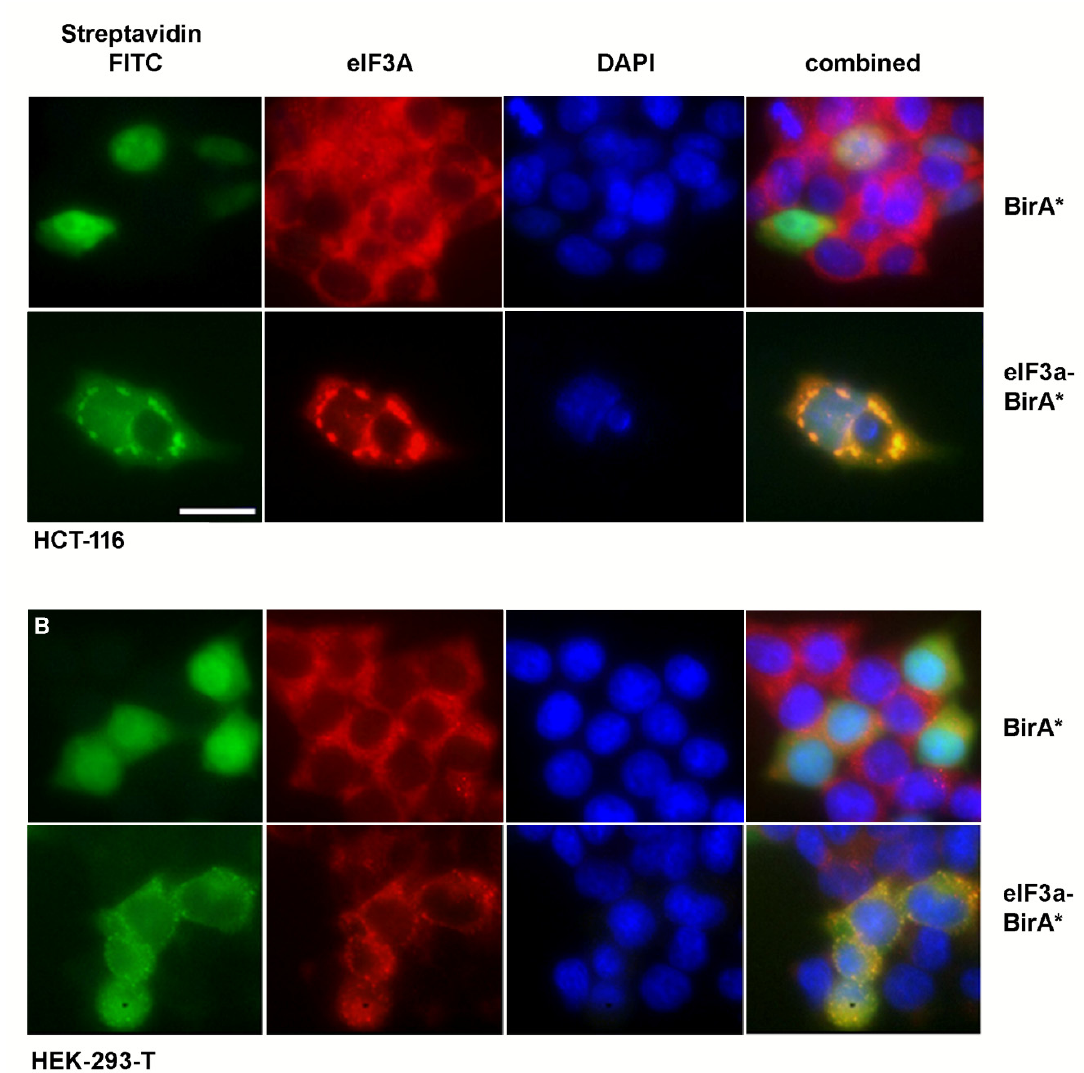
Figure 2. Visualization of biotinylated proteins and eIF3A by immunofluorescence. HCT-116 ( A ) and HEK-293T ( B ) cells were seeded on glass slides, fixed and stained for biotinylated proteins and eIF3A by streptavidine-fluorescein conjugate or indirect immunofluorescence, respectively, as described in the “Materials and Methods” section. Nuclei were counterstained by DAPI. Scale bar indicates 50 µm.